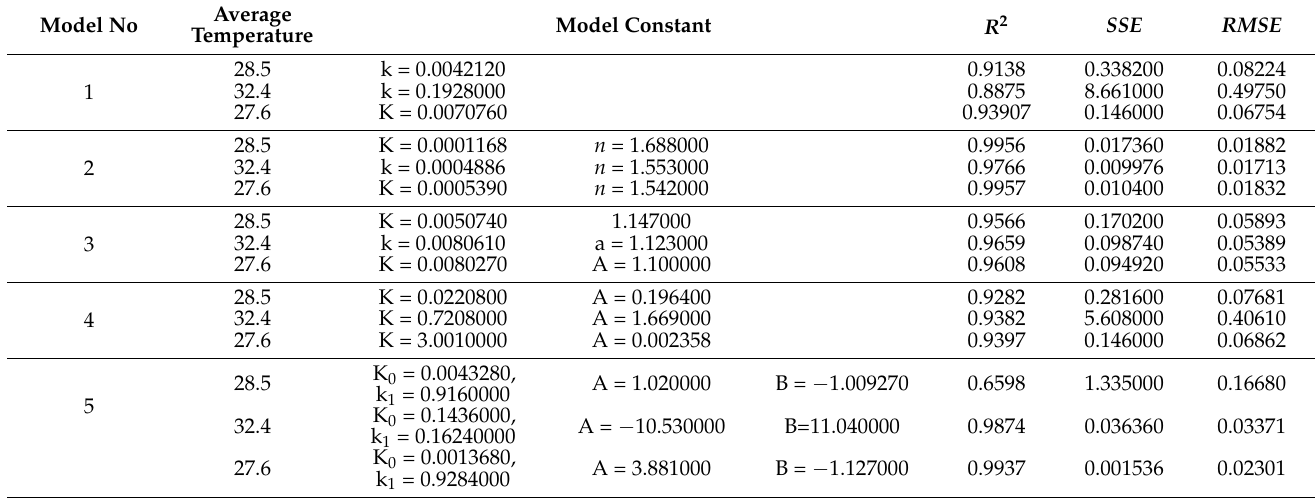
Table 3. Mathematical model fitting under average drying temperature of apricot.